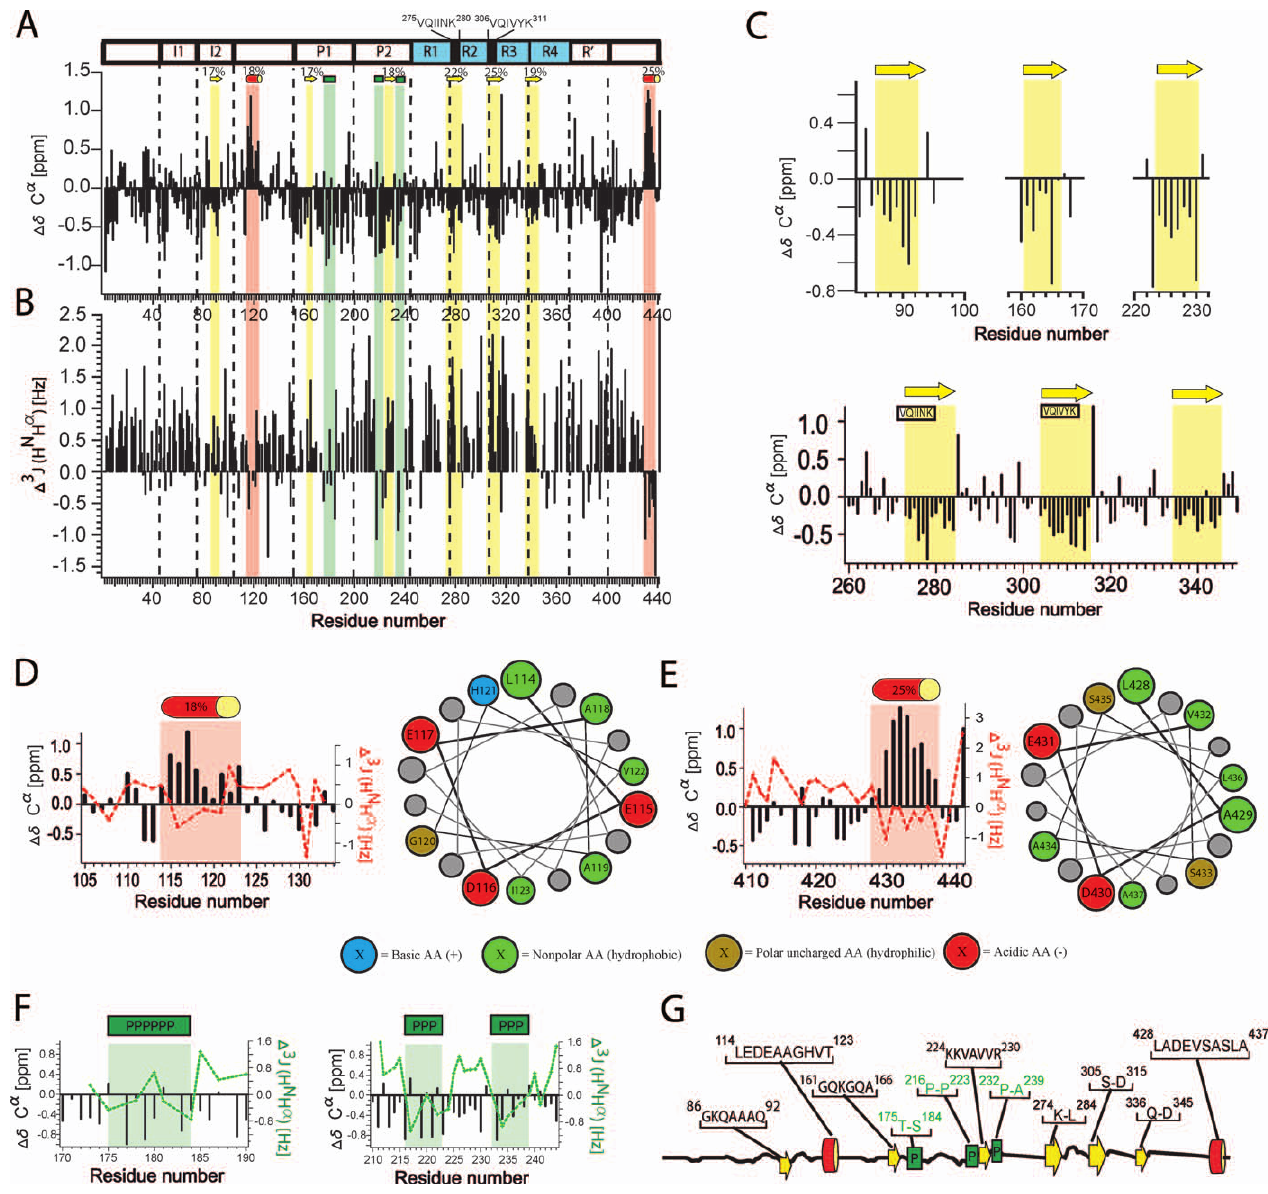
Figure 3. Residual Secondary Structure of Tau in Solution (A) Secondary chemical shifts for C a . Regions of b -structure ( a -helical) propensity are identified by negative (positive) values extending over several residues and are highlighted in yellow (red). Regions that preferentially populate polyproline II helix have negative C a secondary chemical shifts and are marked in green. The domain organization of htau40 is shown above. Repeat boundaries are indicated by vertical dashed lines. (B) Differences between experimental 3 J(H N H a ) scalar couplings and random coil values as a function of sequence number. Regions of b -structure ( a - helical) propensity are identified by positive (negative) values extending over several residues. Regions that preferentially populate polyproline II helix have negative D 3 J(H N H a ) values and can therefore readily be distinguished from b -structure. (C) C a secondary chemical shifts of regions with a propensity to adopt b -structure. (D,E) Comparison of C a secondary chemical shifts with D 3 J(H N H a ) values in regions of transient helical structure. On top, the estimated population of a - helical structure is indicated. Mapping onto a helical wheel reveals two amphiphatic helices. (F) Comparison of C a secondary chemical shifts with D 3 J(H N H a ) values in regions that transiently populate polyproline II helical conformations. (G) Schematic representation of the elements of transient secondary structure in htau40: b -structure (yellow), a -helical (red), polyproline II (green). In case of b -structure propensity, only regions with populations of 17% or more are